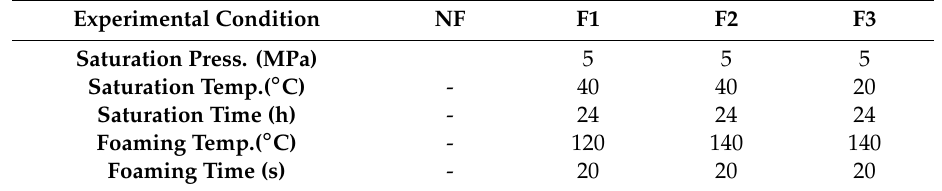
Table 1. Experimental conditions of saturation and foaming process in microcellular foam batch process. Experimental Condition NF F1 F2 F3 Saturation Press. (MPa) 5 5 5 Saturation Temp.( ◦ C) - 40 40 20 Saturation Time (h) - 24 24 24 Foaming Temp.( ◦ C) - 120 140 140 Foaming Time (s) - 20 20